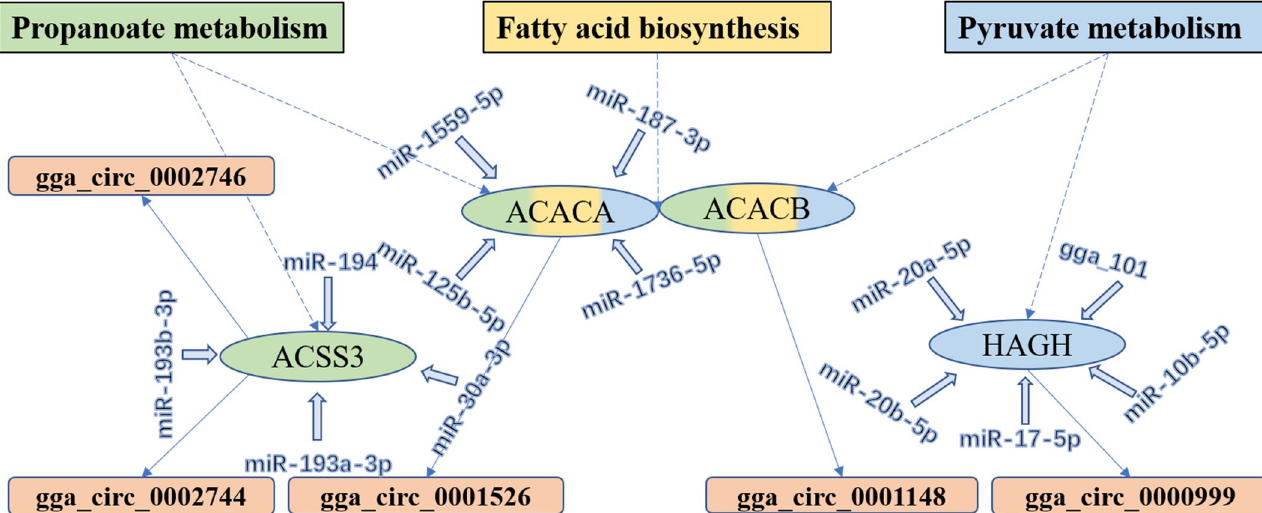
Fig 5. Interaction network of DE mRNAs and DE circRNAs across three pathways in the process of lipid metabolism. The genes within the propanoate metabolism, fatty acid biosynthesis, and pyruvate metabolism pathways are shown in green, yellow, and blue, respectively. The DE mRNAs are the parental gene of DE circRNAs. There are target interactions between DE mRNAs and